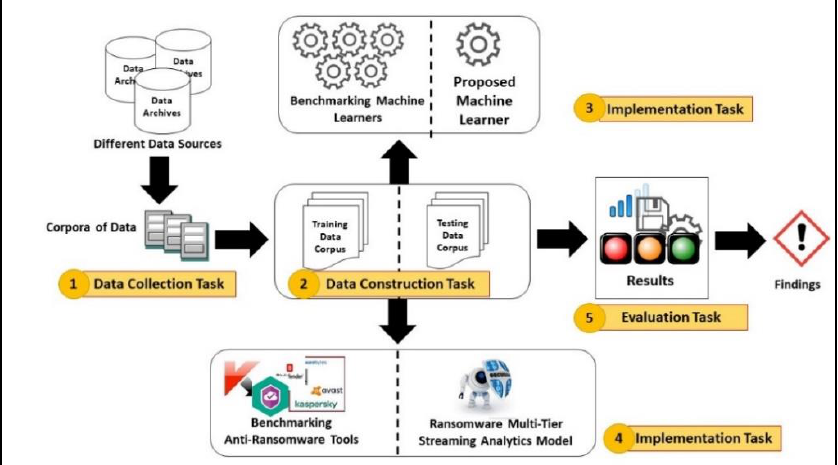
Figure 4. Experimental workflow.